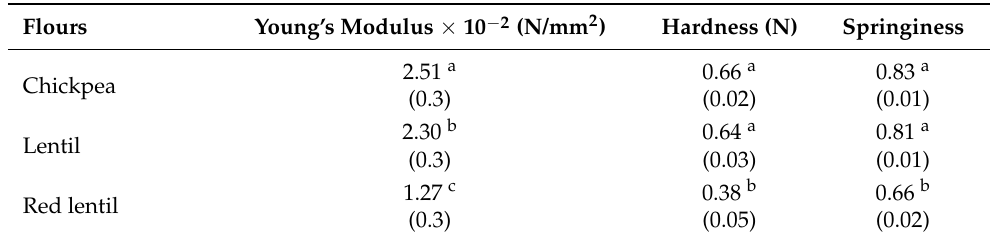
Table 6. Mean values of the Young’s modulus, hardness, and springiness of flour gels. Standard deviation in brackets.